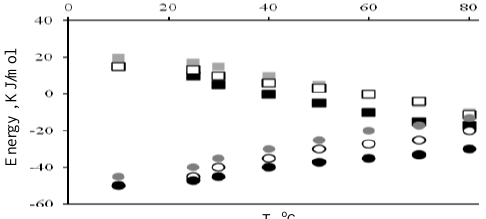
Figure 5. The variations of Δ H ° for three surfactants (Polysorbate-40, Polysorbate-20 and Polysorbate-80 are show by white,